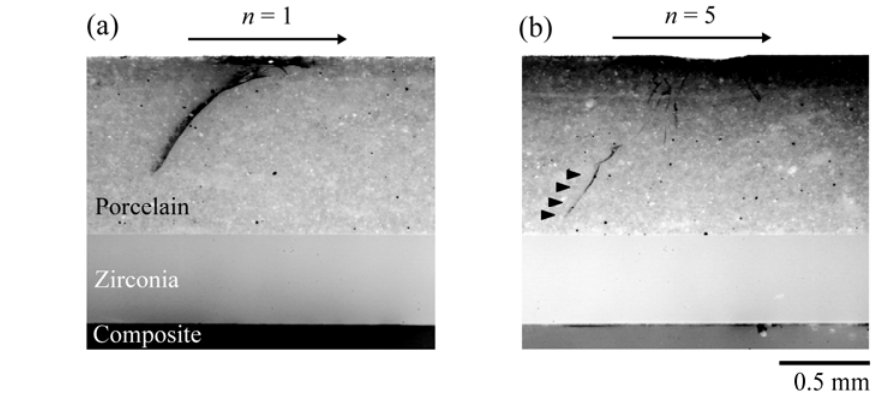
Figure 4. Figure 4 shows light polarized images of (a) a maximum fatigue load of 350 N. A partial cone crack has already propagated ~0.3 mm deep from the occlusal surface after the first loading cycle (black curvy line on the porcelain). (b) shows partial cones formed after 5 cycles. Black solid triangles point to the partial cone penetrating through the entire veneer porcelain.